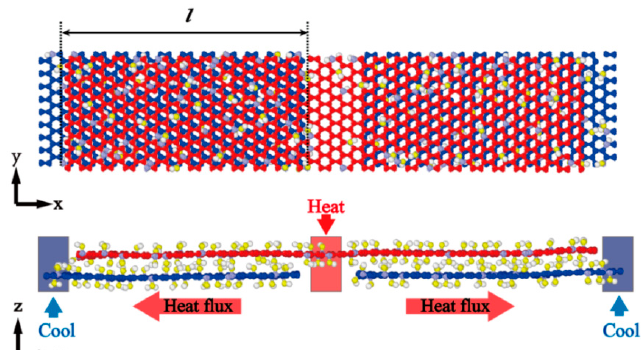
Figure 3. The schematic model for interfacial thermal conductance by the MP algorithm with periodic boundary conditions ( x - and y -axis). The overlap model consists of two GO layers with overlap length ( l ). The heat flow transforms from the upper layer (red) to the lower layer (blue). The system is equally divided into 100 thin slabs along the heat transfer direction. The heat source and sink slabs are located at the middle and the two ends of the model, respectively. The time